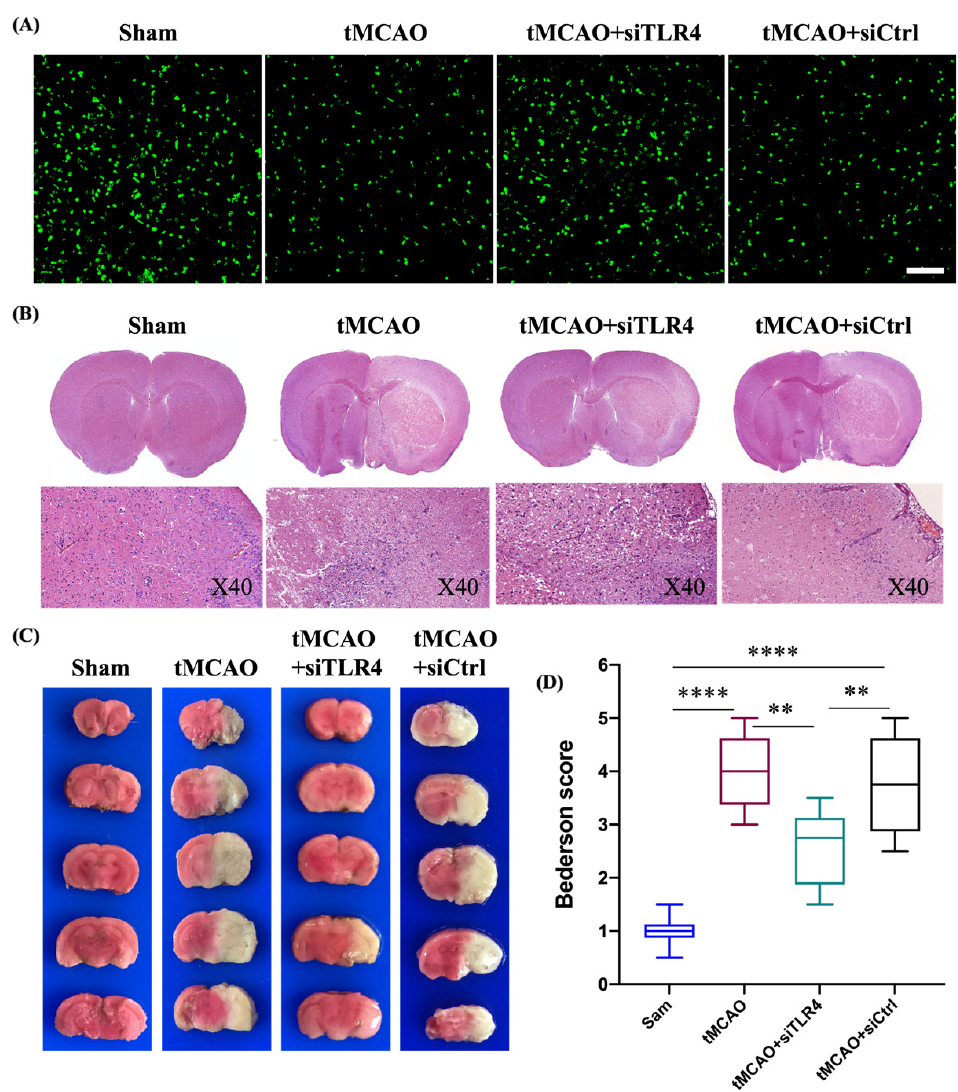
Figure 8. The inhibition of TLR4 by complex of siTLR4/DoGo310 attenuates cerebral I/R injury in mice at 3 d after injection. ( A ) Representative images of NeuN-positive cells in the infarct region. Scale bar = 100 mm. ( B ) H & E staining in tMCAO mouse brain with higher-magnification images (lower panel, magnification: 40×). ( C ) TTC staining of brain sections from each group of mice. ( D ) Neurological scores 72 h after administration of siRNA/DoGo310 complexes. n = 6 mice. ** p < 0.001, **** p < 0.00001.